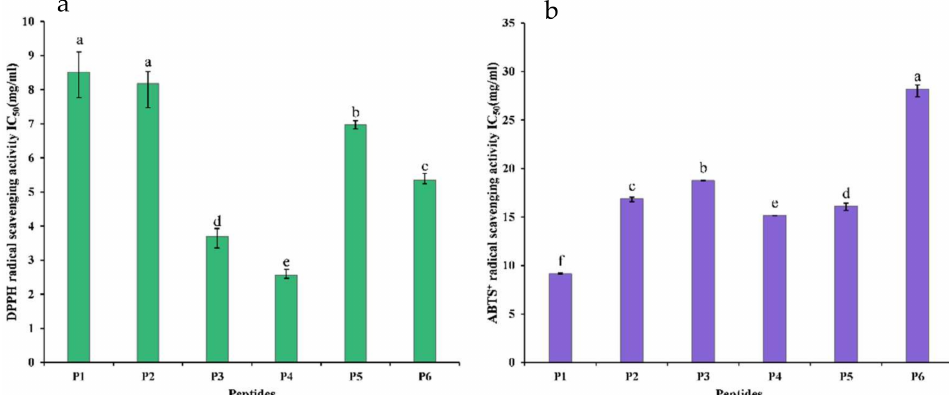
Figure 2. Antioxidant capacity of synthetic peptides after identification by LC–MS/MS (P1: